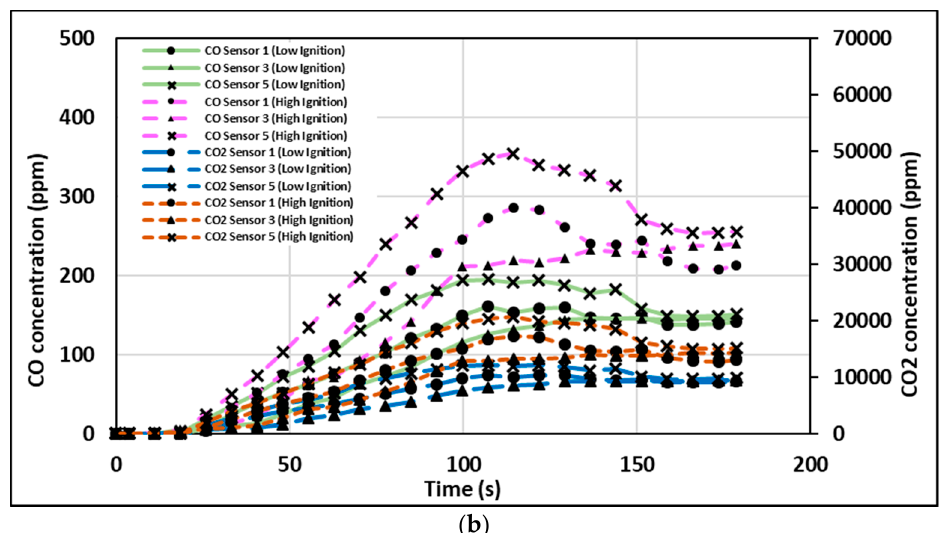
Figure 11. ( a ) Temperature variations due to ignition energy. ( b ) Carbon gases concentrations for different ignition energies.